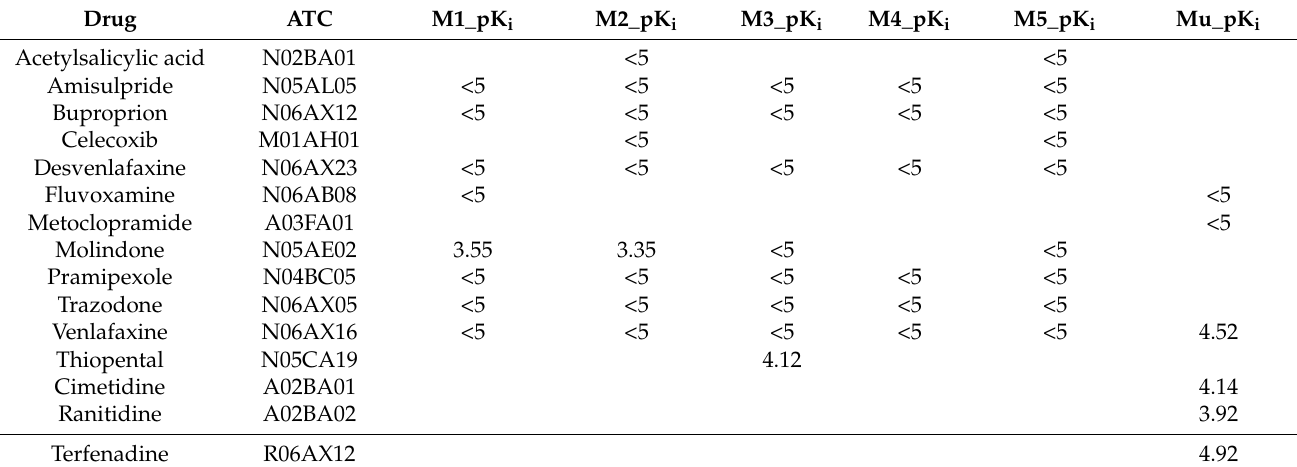
Table 4. Drugs excluded from the final list for having pKi values lower than